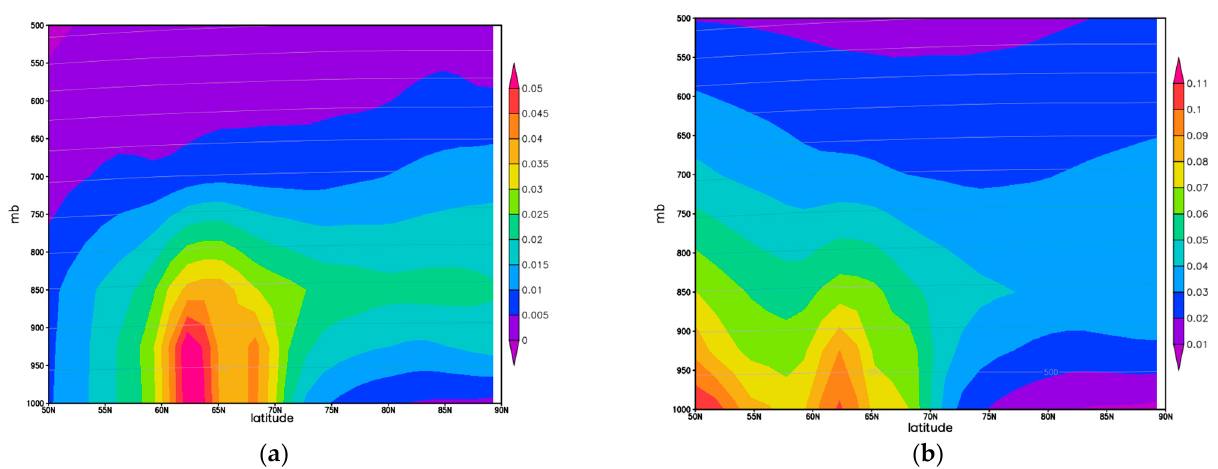
Figure 14. Vertical profile of the ensemble mean zonal average anomaly of BC concentration ( a ), total BC concentration in the experiment with forest fires ( b ), August, μ g/m 3 . The isolines of the geopotential height with an interval of 500 m are shown in gray.